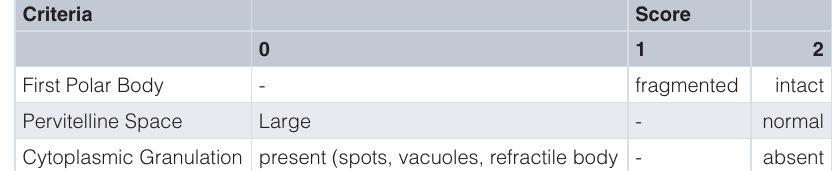
Table 2. Modification of Xia morphological